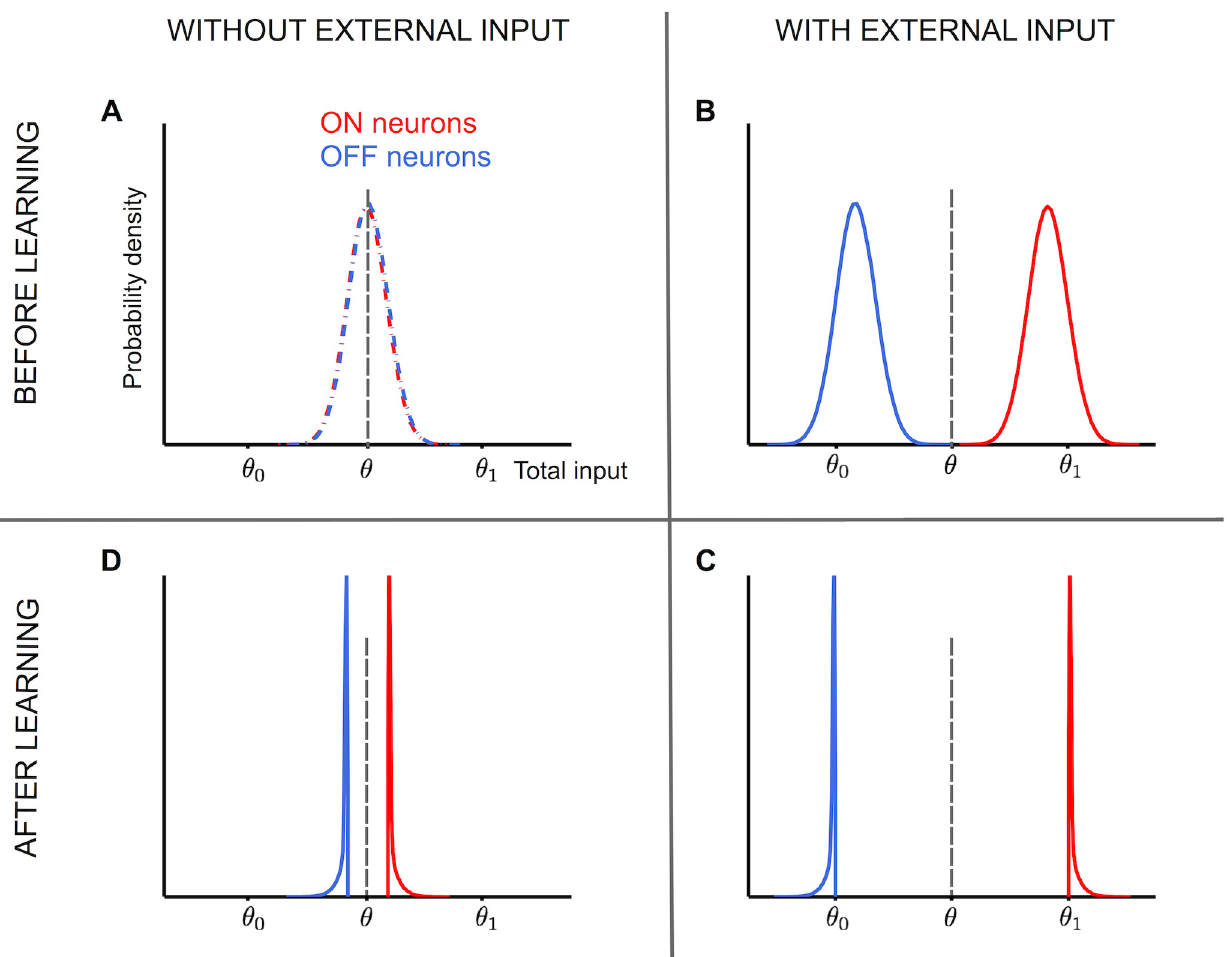
Fig 3. Distribution of local fields before and after learning for f = 0.5 and non-zero robustness. A. Before learning begins, the distribution of local field of neurons is a Gaussian distribution (due to central limit theorem) centered around neuronal threshold θ both for neurons with the desired output zero (OFF neurons) and with the desired output one (ON neurons). The goal is to have the local field distribution of ON neurons (red curve) to be above the threshold θ , and that of OFF neurons to be below θ . B. Once any of the to-be-stored patterns are presented as strong external fields, right before the learning process ffiffiffiffi p N , whereas the distribution of the ON neurons moves starts, the local field distribution of the OFF neuron shifts toward the left-side centered around y 0 þ f (cid:2) ffiffiffiffi p N , with a negligible overlap between the two curves if the external fi eld is strong enough. Thanks to the strong toward the right-side, centered around y 1 (cid:2) f (cid:2) external fi elds and global inhibition, the local fi elds of the ON and OFF neurons are well separated. C. Due to the learning process, the local fi elds within the depression region [i.e. ( θ 0 , θ )] get pushed to the left-side, below θ 0 , whereas those within the potentiation region get pushed further to the right-side, above θ 1 . If the learning process is successful, it will result in a region ( θ 0 , θ 1 ) which no longer contain local fi elds, with two sharp peaks on θ 0 and θ 1 . D. After successful ffiffiffiffi p N learning, once the external fi elds are removed, the blue and red curves come closer, with a gap equal to 2 f (cid:2) . The larger the robustness parameter (cid:2) , the more the gap between the left- and right-side of the distribution. Notice that now the red curve is fully above θ which means those neurons remain stably ON, while the the blue curve is fully below θ , which means those neurons are stably OFF. Therefore the corresponding pattern is successfully stored by the